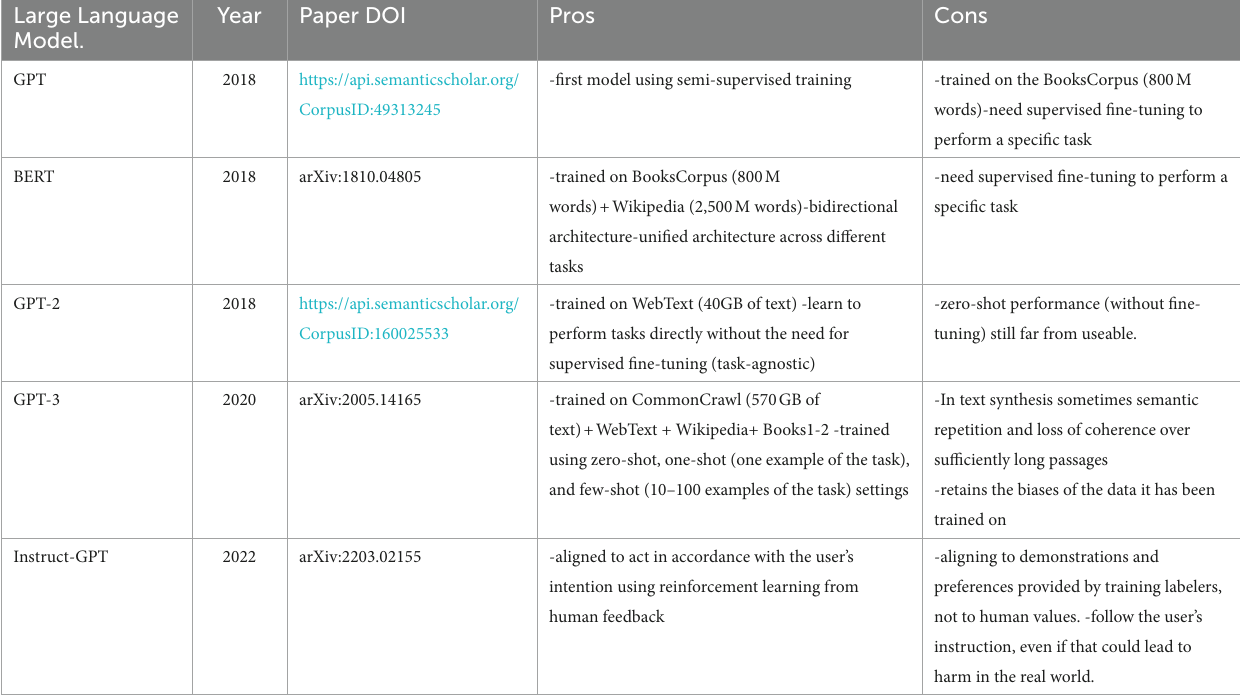
TABLE 1 Large language models evolution toward ChatGTP: pros and cons of each model Large Language